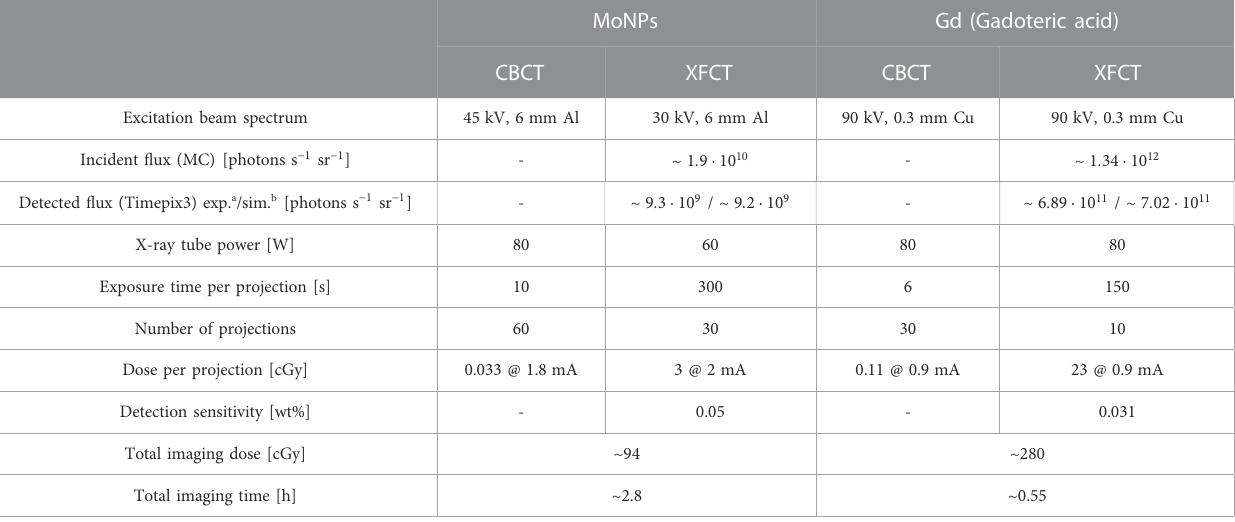
TABLE 1 System characteristics and imaging metrics for CBCT and XFCT scans performed with MoNPs and conventional Gd-containing contrast agents.